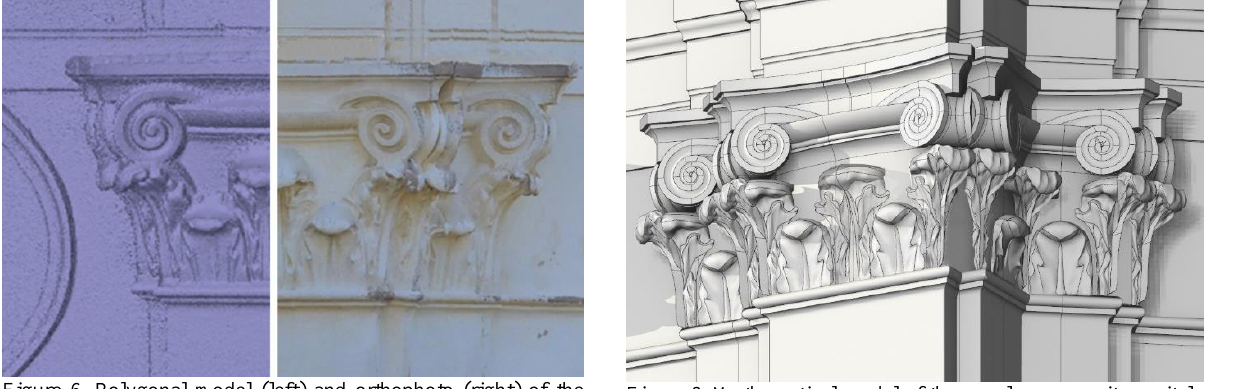
Figure 8. Mathematical model of the angular composite capital.